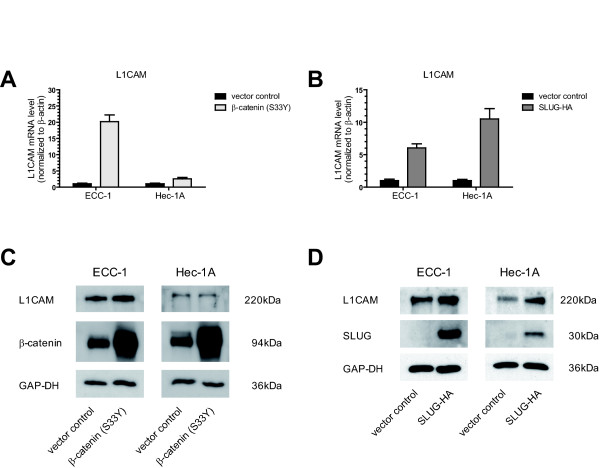
L1CAM mRNA and protein levels in endometrial carcinoma cell lines overexpresssing transcription factors β-catenin or Slug. (A) Regulation of L1CAM expression after transfection of a point mutated, constitutively active form of β-catenin (S33Y) or control pcDNA3 plasmid as determined by qRT-PCR using specific primers. (B) Regulation of L1CAM levels after overexpression of a HA-SLUG or control plasmid. Means ± SD from n = 3 independent experiments are shown. (C) Western blot analysis for L1CAM and β-catenin as well as GAP-DH, used as a loading control. (D) Western blot analysis for L1CAM and anti SLUG as well as GAP-DH, used as a loading control. A representative experiment from n = 3 is shown.